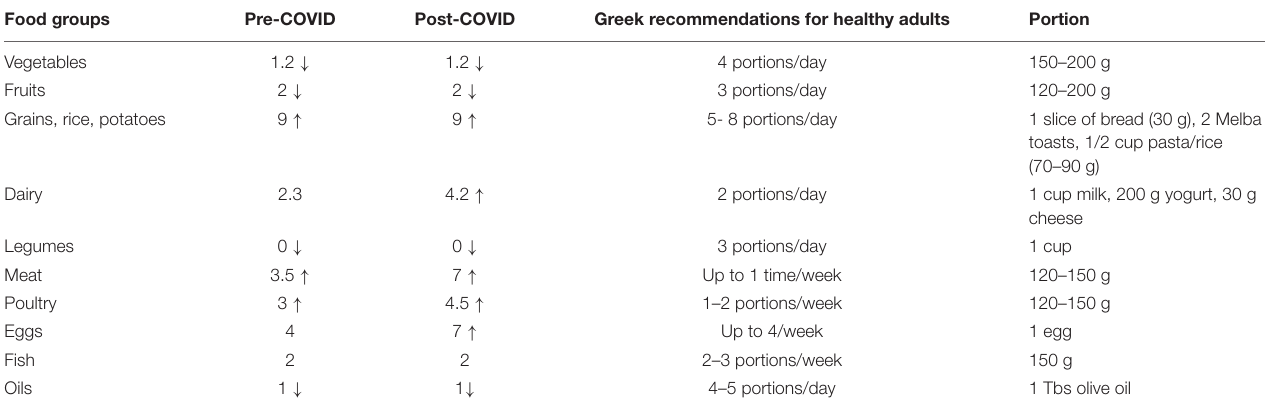
TABLE 2 | Daily or weekly frequencies of foods provided and comparison with Greek recommendations of the healthy population. Food groups Pre-COVID Post-COVID